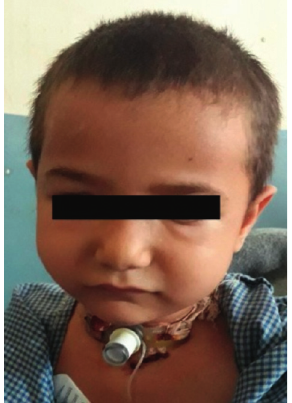
Figure 4: On the 1 st postoperative